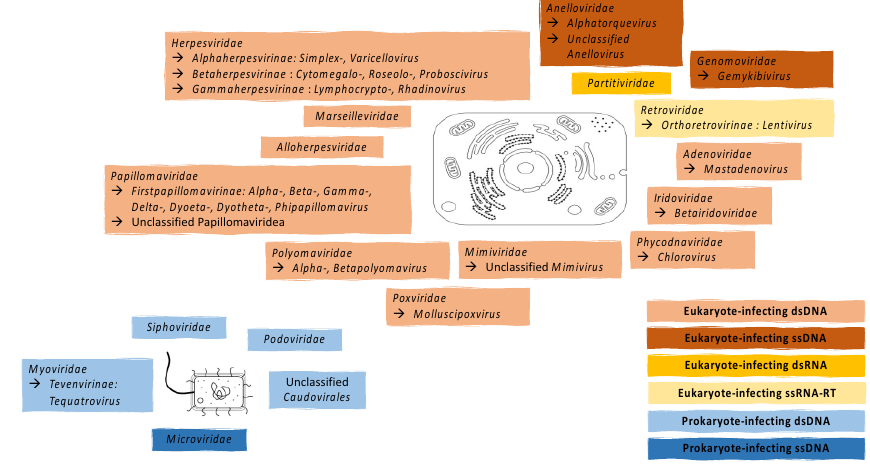
Figure 1. Current knowledge on eukaryote- and prokaryote-infecting vaginal viruses: The families, subfamilies and genera of eukaryote-infecting viruses, including double-stranded (ds) DNA, single-stranded (ss) DNA, dsRNA and ssRNA reverse transcribing (ssRNA-RT) viruses, as well as prokaryote-infecting dsDNA and ssDNA viruses that have been described in literature are listed.